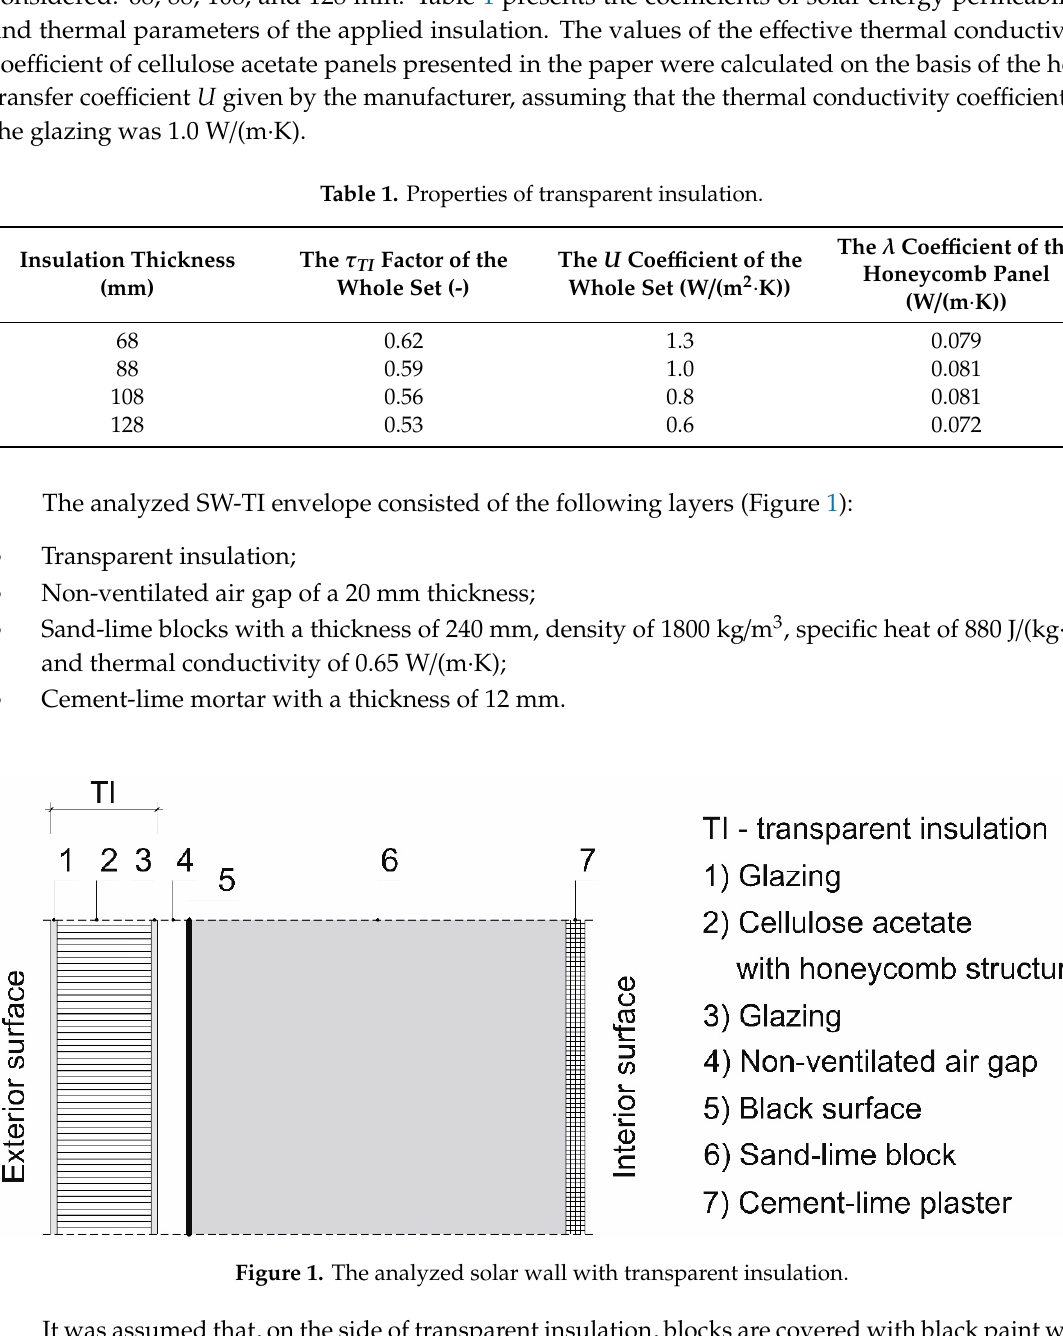
Table 1. Properties of transparent insulation.